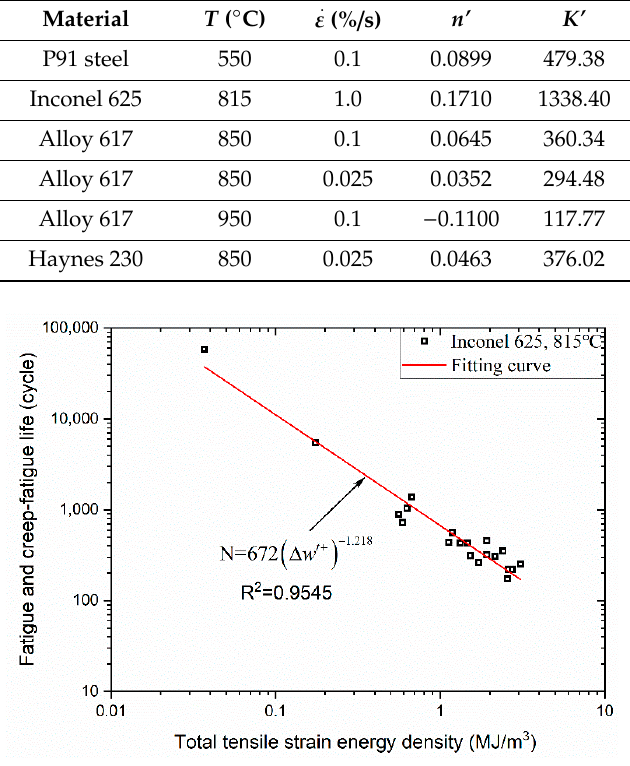
Figure 4. The cyclic stress strain relation of Inconel 625 at 815 °C.